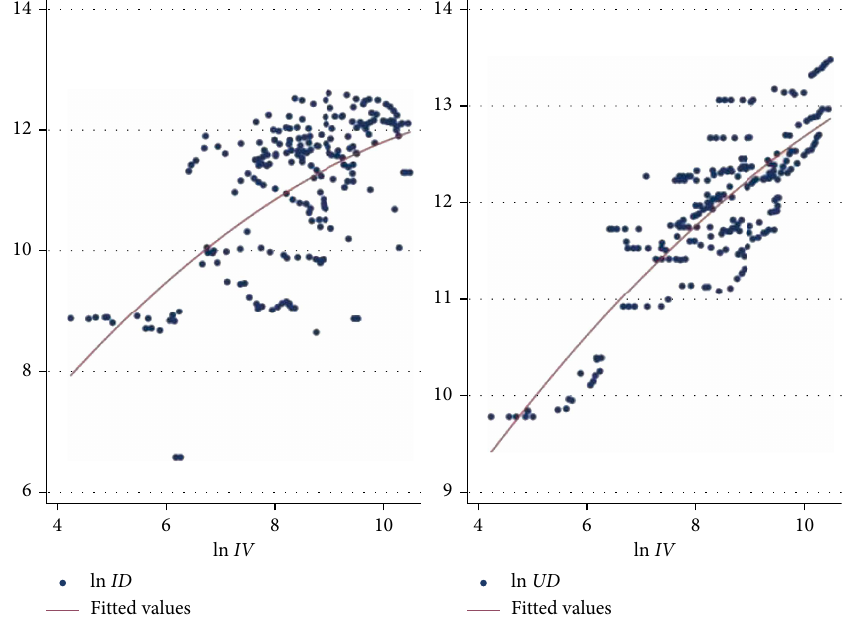
Figure 7: Inspection of the Kuznets curve of water